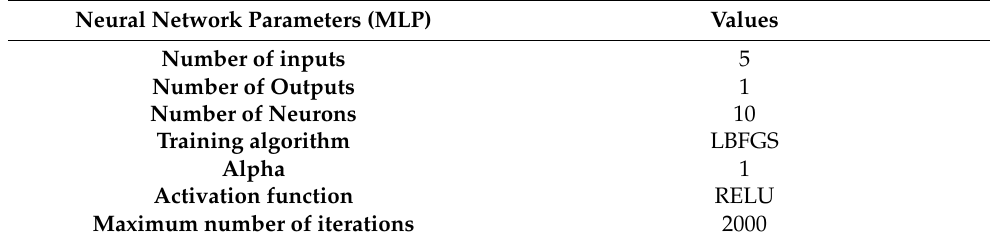
Table A1. Description of final optimized hyperparameters for artificial neural network ensemble.